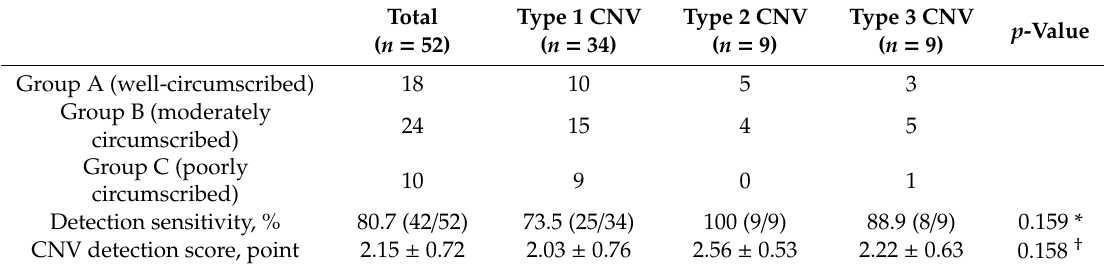
Table 4. Choroidal neovascularization (CNV) visualization group, CNV detection sensitivity, and CNV detection score according to CNV subtype.